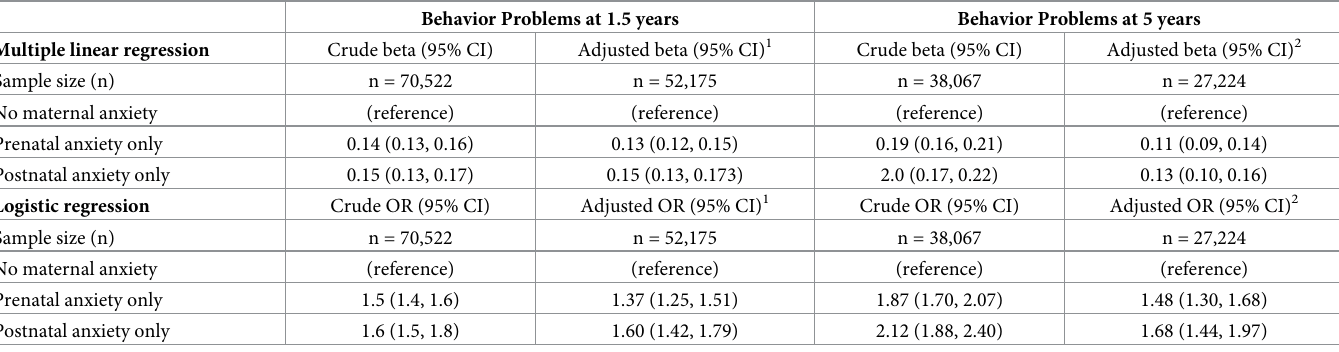
Table 3. The effect of maternal anxiety on child behavior problems at 1.5 and 5 years (full cohort).